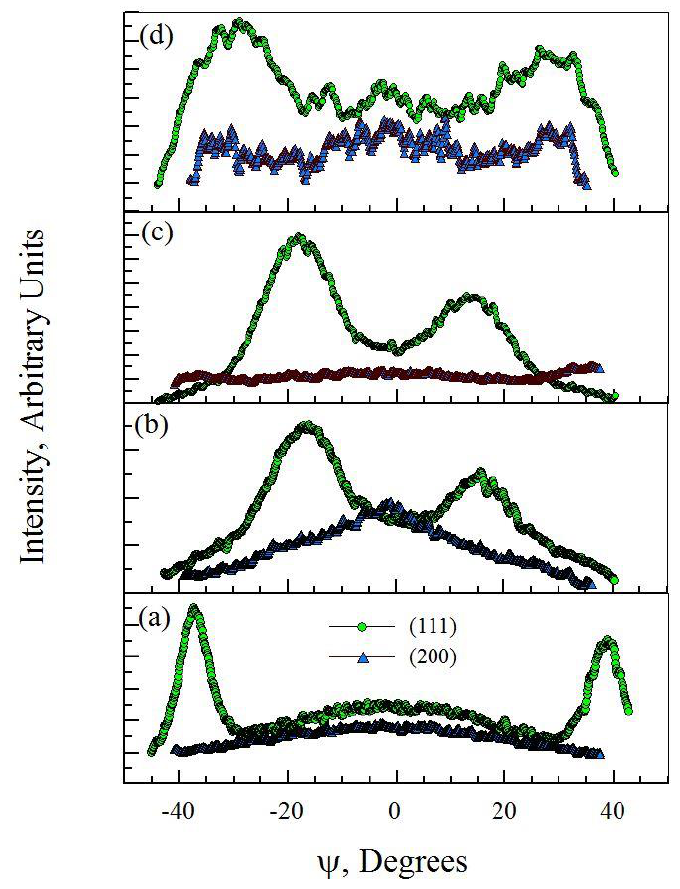
Figure 4. (111) and (200) rocking curves for the films in Group 4, with  values ranging from − 50° to +50°. Deposited films are: ( a ) G4-RT; ( b ) G4-150; ( c ) G4-250 and ( d )